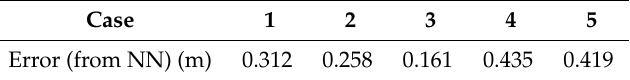
Table 1. The maximum values of the